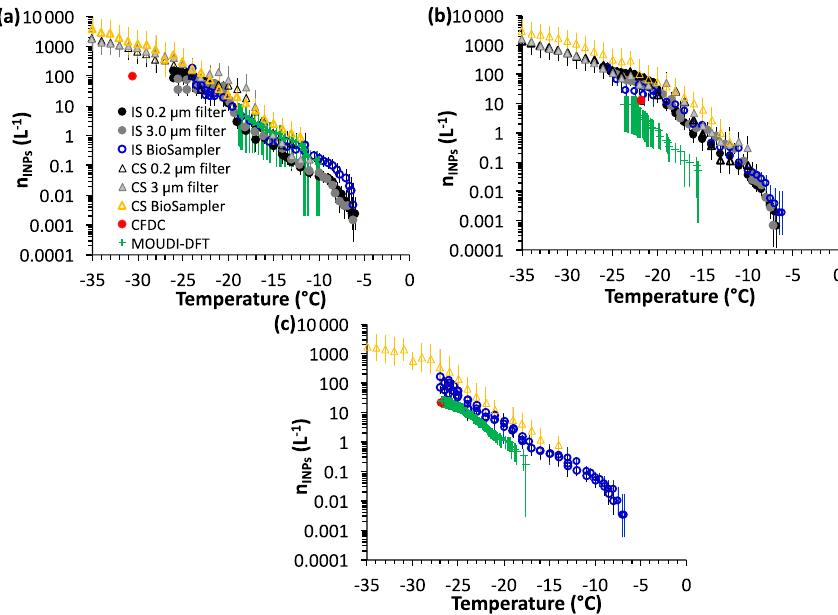
Figure 2. Three additional experimental comparison days, as in Fig. 1 but for cases where all four methods were operational for consistent sampling periods. These dates were 12 –14 November in panels (a) – (c) , respectively. The legend is shown in panel (a) . The additional data in green are from the MOUDI-DFT method (all sizes included), including median (cross) and upper and lower